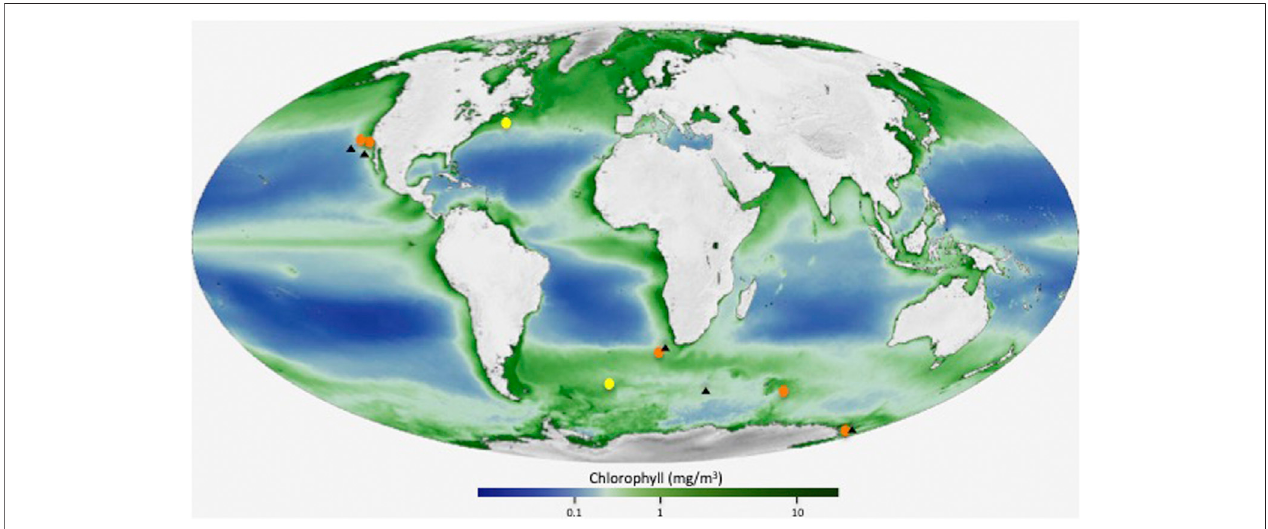
FIGURE 1 | Location map showing the analyzed stations (orange color), and two previously analyzed sites (yellow color) in the North Atlantic and in the Atlantic sector of the Southern Ocean (Martinez-Ruiz et al., 2019). Black triangles indicate the location of the stations with available Ba concentration depth pro fi les used for Ω fi ed from NASA/Goddard Space Flight Center, The SeaWiFS Project and GeoEye maps, https://svs.gsfc.nasa.gov/30801). barite calculations. Base map modi